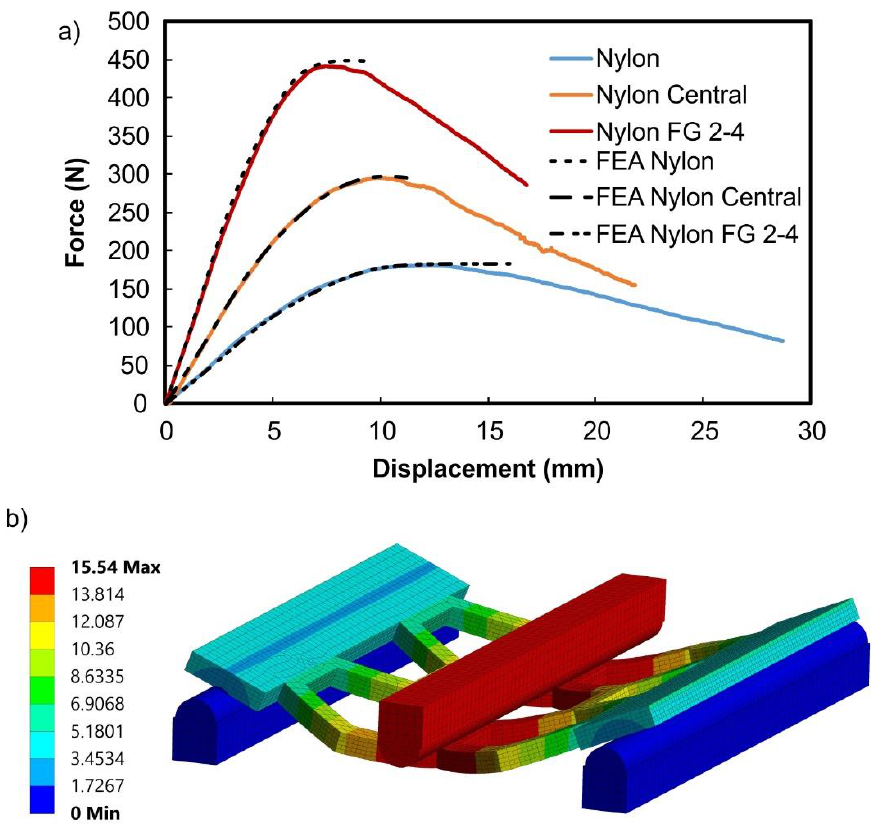
Figure 9. ( a ) Force-deflection curves of experimental and FEA for Nylon, Nylon FG central and Ny- lon FG, top 2–4 positions; and ( b ) typical deformation (mm) response of the FE model under three- point bending.